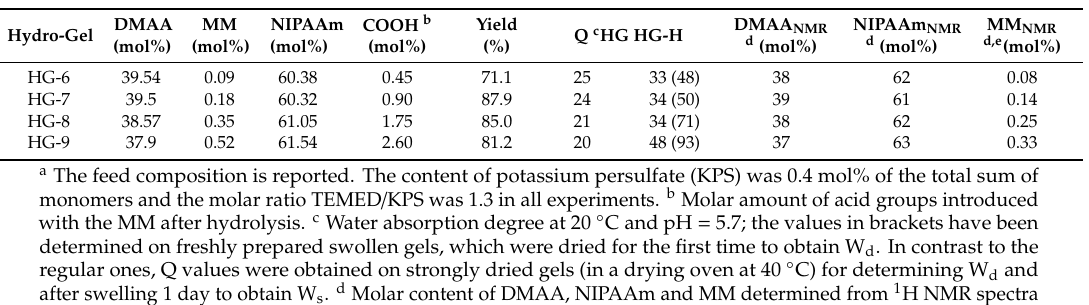
Table 2. Synthesis of hydrogels based on N,N -dimethylacrylamide, N -isopropylacrylamide